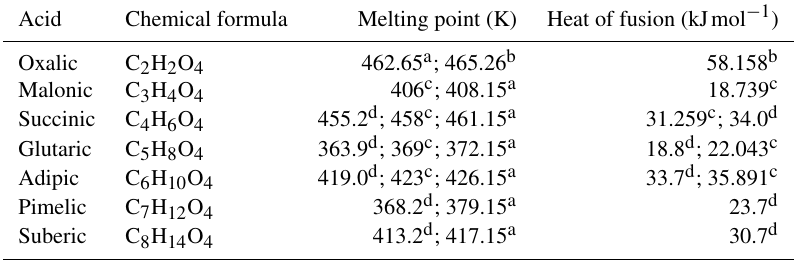
Table 1. List of the studied α , ω -dicarboxylic acids and their experimentally determined melting points and heats of fusion. The values were measured using anhydrous acids (crystalline at 298.15K). The melting point of oxalic acid reported by Booth et al. (2010) (370K) is likely the temperature of the phase transition from dihydrate to anhydrous crystal polymorph. Similar transition was seen by Omar and Ulrich (2006) at 378.35K in their differential scanning calorimetry experiment.